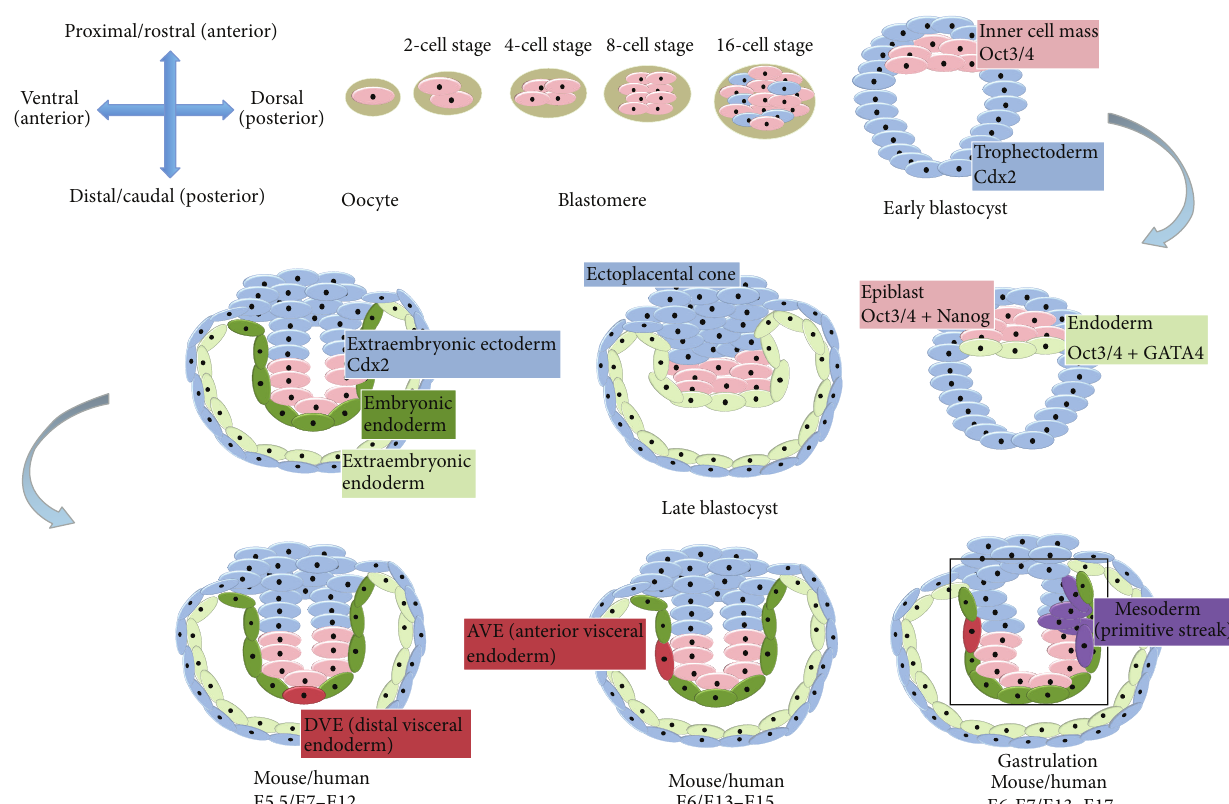
Figure 1: Developmental stages of mouse embryo. First row (left to right), from the secondary oocyte the blastomere develops (2-cell, 4- cell, 8-cell, and 16-cell stages) to give rise to the early blastocyst formed of trophectoderm (cells that express Cdx2) and inner cell mass cells (that express Oct3/4). Later, the inner cell mass gives rise to the epiblast (cells that express Oct3/4 and Nanog) and endoderm (expressing Oct3/4 and GATA4). Second row (right to left), in the late mouse blastocyst Cdx2 positive cells give rise to the extraembryonic ectoderm and ectoplacental cone. At the same time the endoderm divides into an embryonic endoderm and an extraembryonic endoderm. The epiblast and the extraembryonic ectoderm form a cavity lined by embryonic endoderm. From the embryonic endoderm the distal visceral endoderm is formed (DVE). Third row (left to right), the DVE migrates proximally and will be known as the anterior visceral endoderm (AVE). The final image (third row, right) shows the development of the primitive streak (mesodermal cells) at the opposite (posterior) pole from the AVE. N.B. There are 2 different types of endoderm called extraembryonic and embryonic; these differ in their potency and give rise to distinct cellular derivatives. All timelines are given for mouse and human embryonic